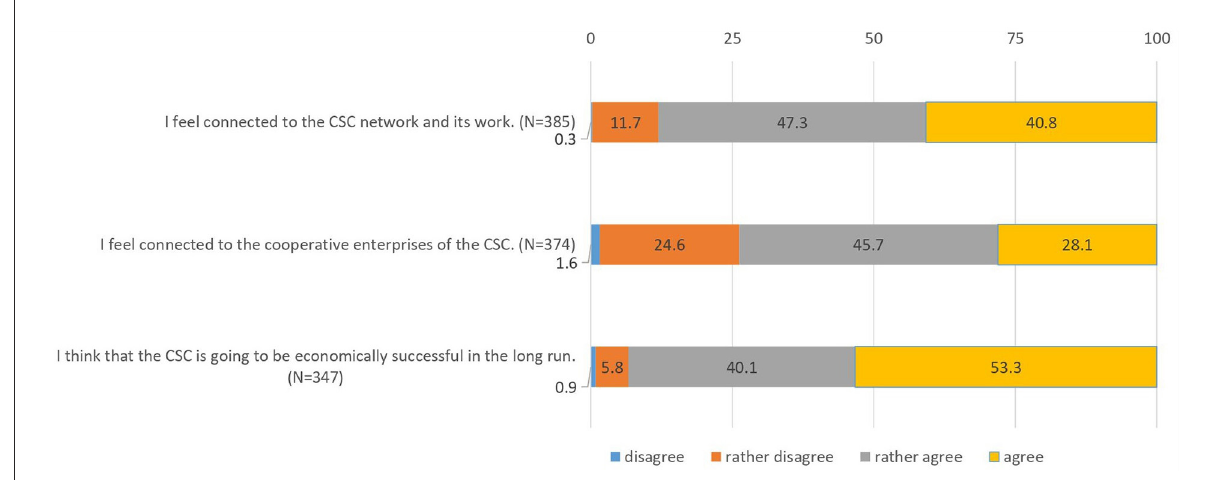
FIGURE1 The shareholders sense of connectedness toward the supported food enterprises and the CSC network, as well as their confidence in the long-term economic